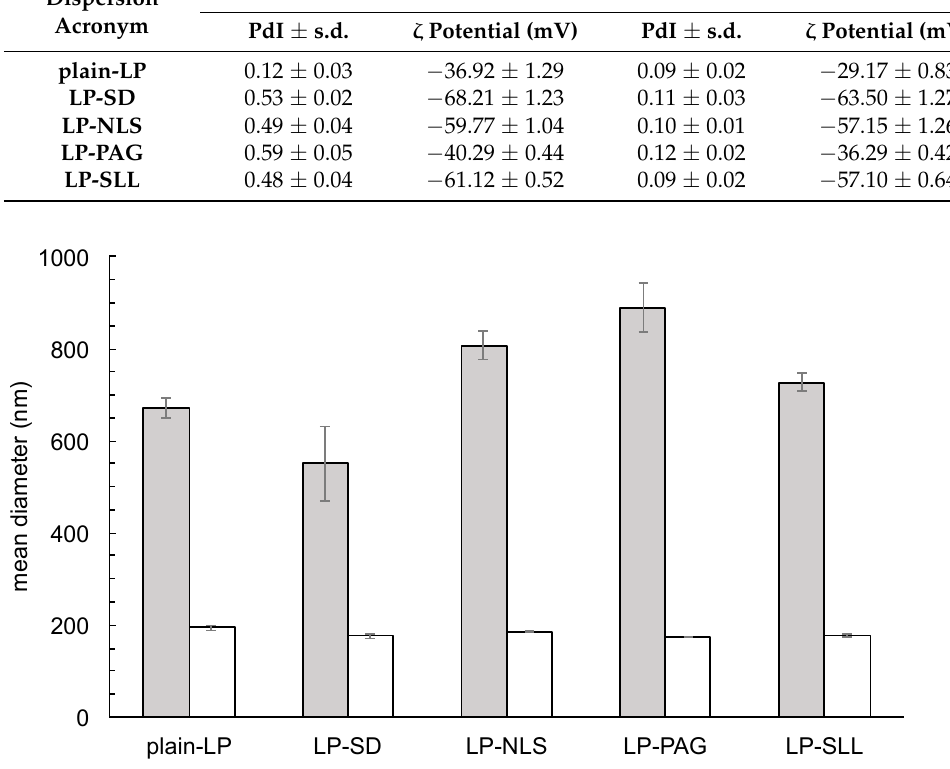
Figure 3. Mean diameter of the produced anionic liposomes before (grey) and after (white) extrusion through 200 nm pore size polycarbonate filters as determined by PCS, p -values < 0.05.